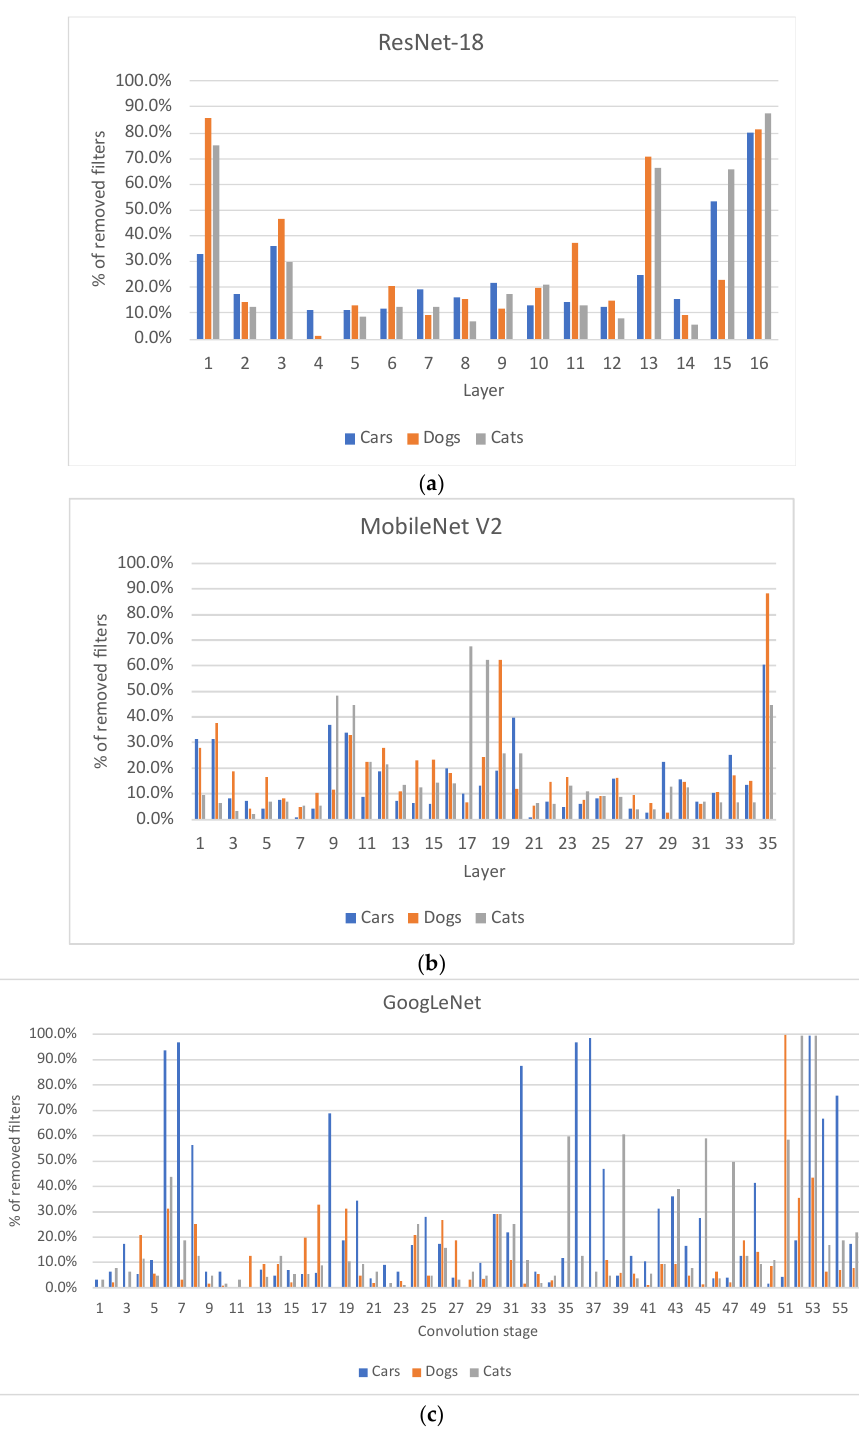
Figure 6. Percentages of filters removed by S-VELCRO in every mode layer for ( a ) ResNet-18, ( b ) MobileNet V2, and ( c ) GoogLeNet.